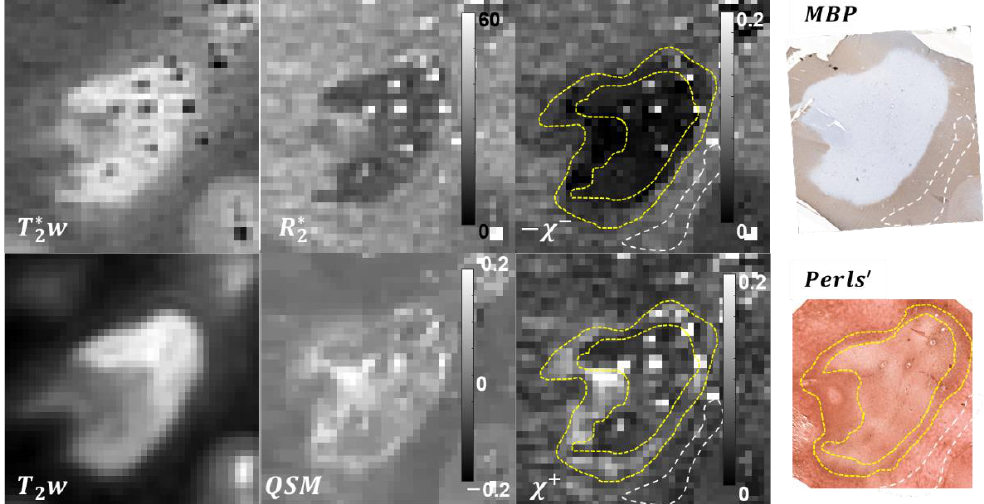
Figure 1. Results of the 𝑹 𝟐∗ -based separation of magnetic sources in a chronic active lesion. Paramagnetic lesion rim readily identifiable in QSM and 𝝌 + (yellow dashed line) appears to be in good morphological agreement with the iron distribution revealed by Perls’ staining. Similarly, strong demyelination of the lesion core estimated with the proposed method is well reflected by the MBP staining. NAWM is shown with white dashed line.